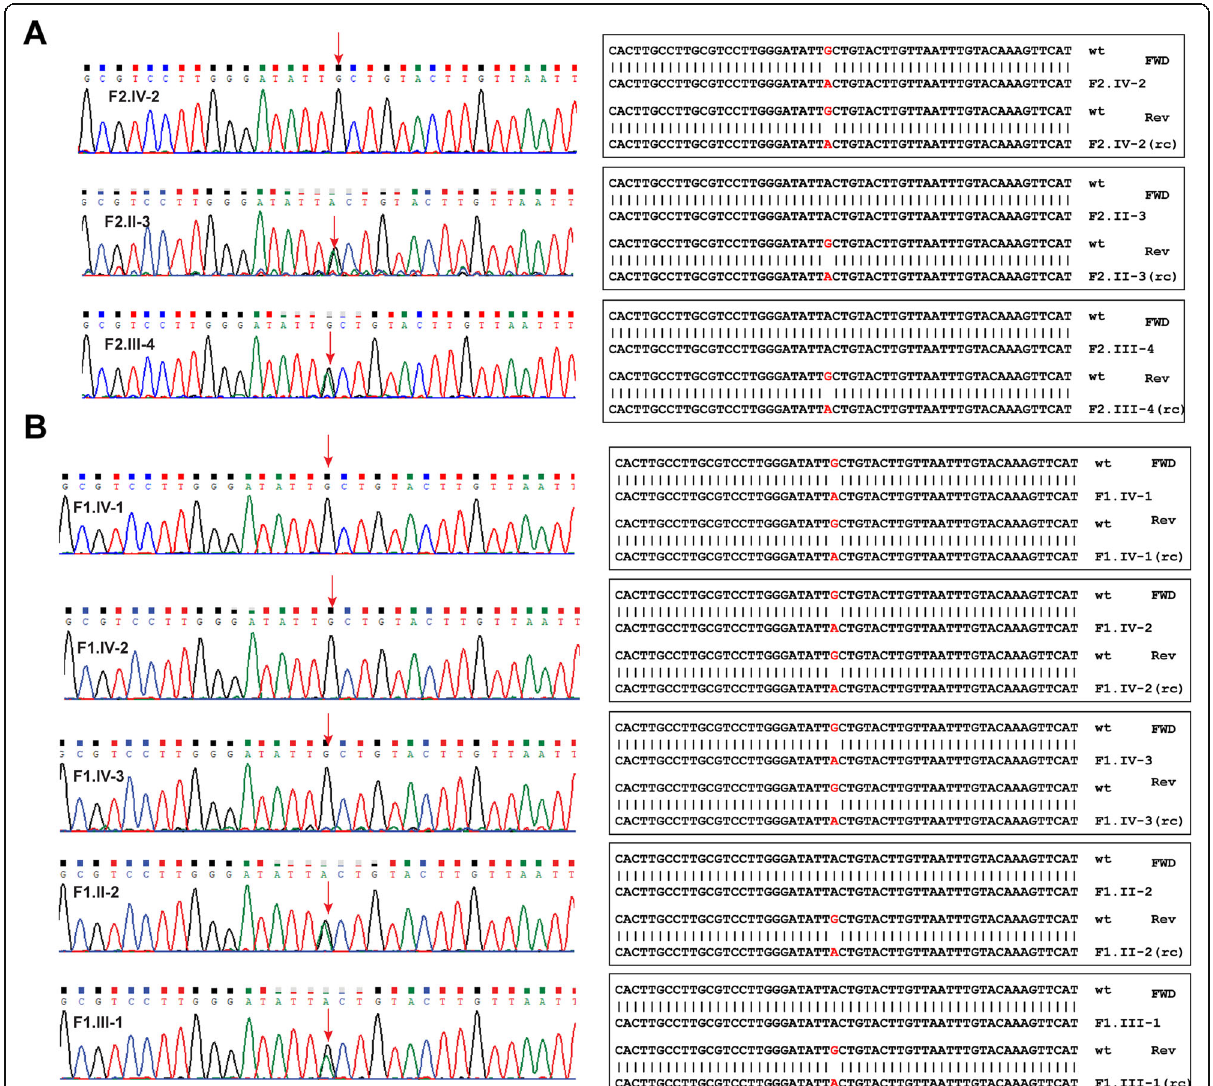
Fig. 2 Sanger validation of KIAA1109 mutation in patients and their parents. Figure depicting chromatogram, and sequence alignments of Sanger results of KIAA1109 mutation g.123140678A > G of a F2.IV-2 and his parents and b patients F1.IV-1, F1.IV-2 and F1.IV-2 and their parents (index family). The mutated nucleotides are shown by red arrow (in chromatogram) or marked red (in sequence alignment). Sequence alignments are shown for both forward and reverse strands sequences to depict the homozygosity (in patients) or heterozygosity (in parents). Reverse